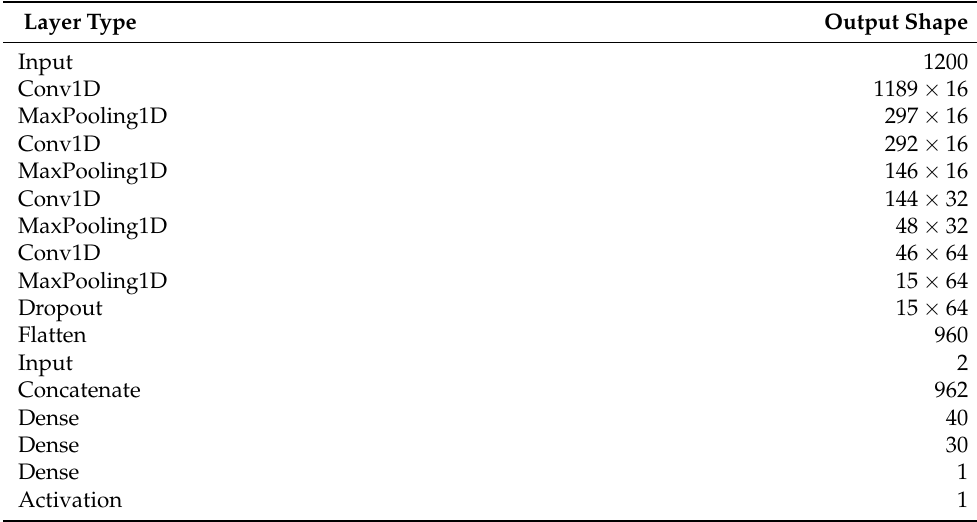
Table 1. Description of layers used in the model to identify impulsive signals. For each layer, the dimension of the layer output is